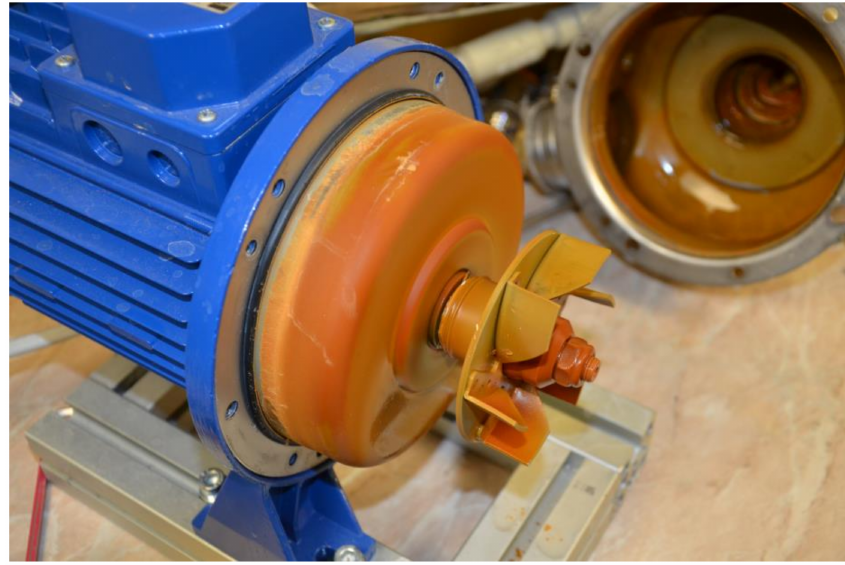
Figure 14. Incrustation on PUMP-2 where no flushing was